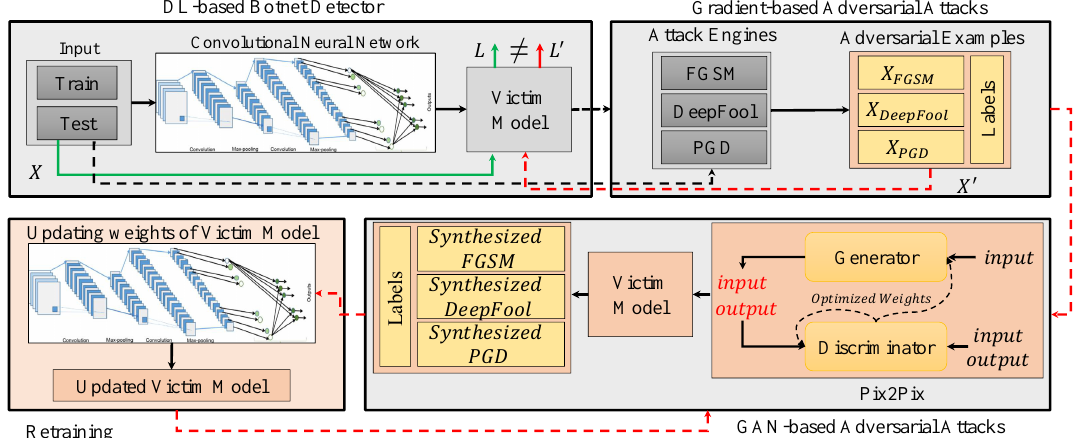
Figure 5. General architecture of our proposed attack and defense system. In the retraining process the weights of the victim model are being updated in each iteration, thus improves its decision boundaries. In return, this process also yields to more powerful adversarial examples after each